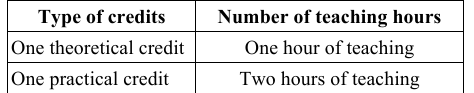
Table 4. Number of credit in comparison to hour of teaching